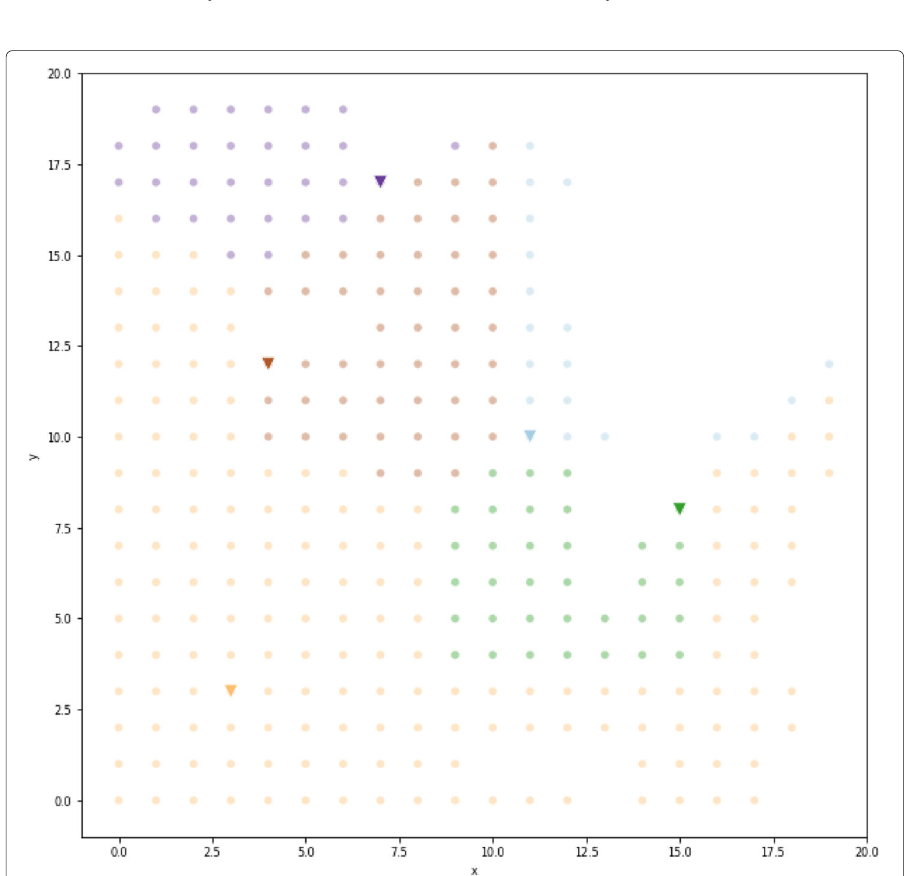
Fig. 8 Trained SOM Each point represents a SOM node. The color represent clusters. The triangle represents the node activated by the center of the corresponding cluster. Nodes showing no color have not been activated during the training